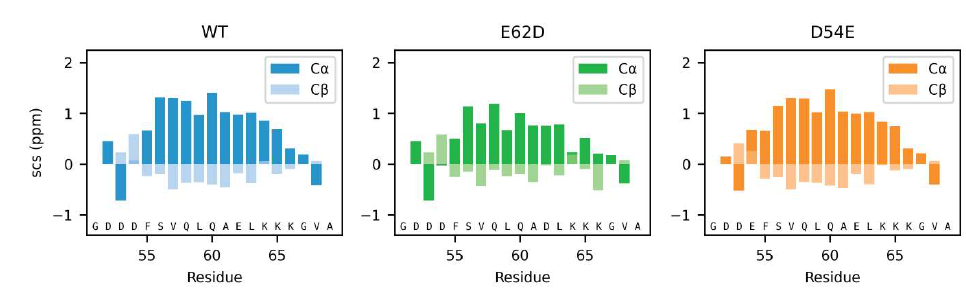
Figure 7. Local effects of Asp and Glu in helix stabilization. The SCS of the Cα and Cβ atoms of the three peptides corresponding to WT, D54E and E62D in the context of Dss1 51–69 .